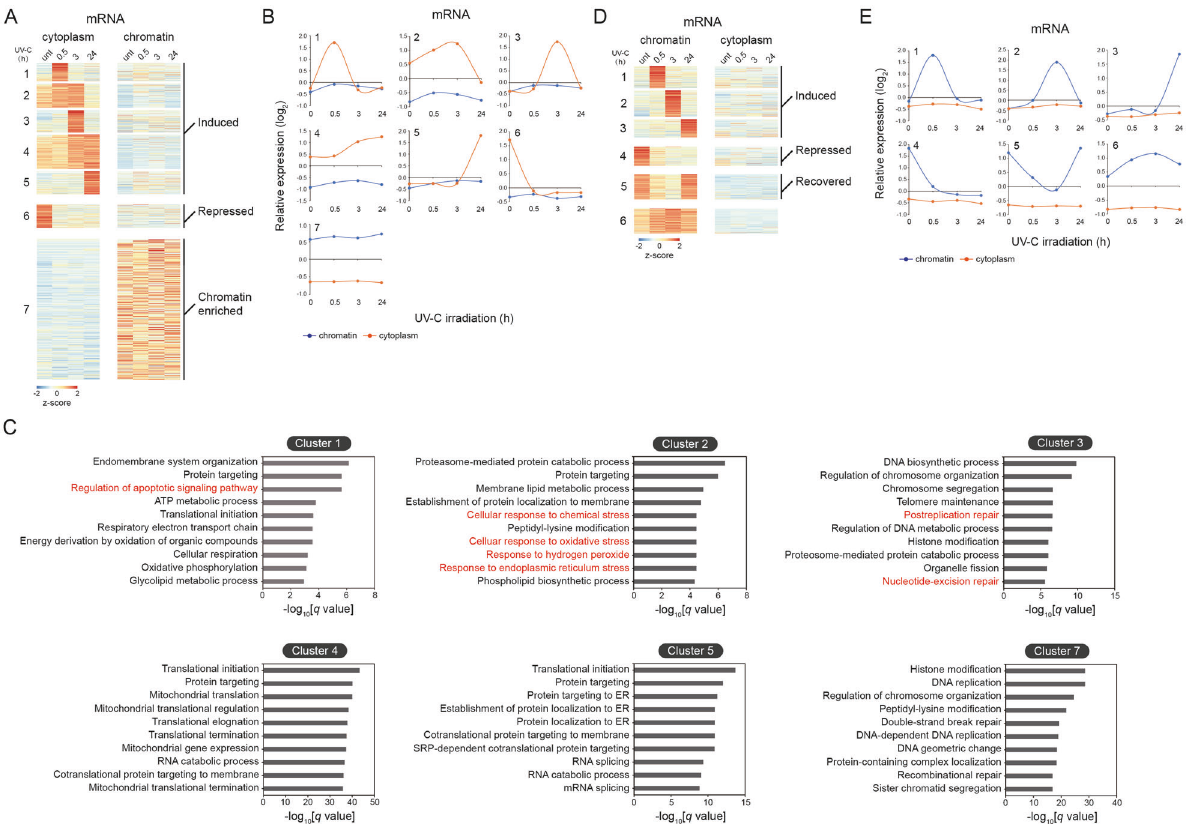
Fig. 3 Dynamic transcriptional programs of mRNAs in response to UV-C irradiation. A Heat-map diagram showing the seven clusters of differentially expressed transcripts in the cytoplasm fraction following UV exposure. Color key represents relative expression on a log 2 scale. B The average relative transcript levels within each cluster presented in Fig. 3A are shown, with the log2 expression values on the y axis and time on the x axis. C Top 10 gene ontology enrichments of genes in clusters 2 – 5 and 7 with Bonferroni-corrected P values. D Heat-map diagram showing the six clusters of differentially expressed transcripts in the chromatin extract following UV exposure. Color key represents relative expression on a log 2 scale. E The average relative transcript levels within each cluster presented in Fig. 3D are shown, with the log2 expression values on the y axis and time on the x